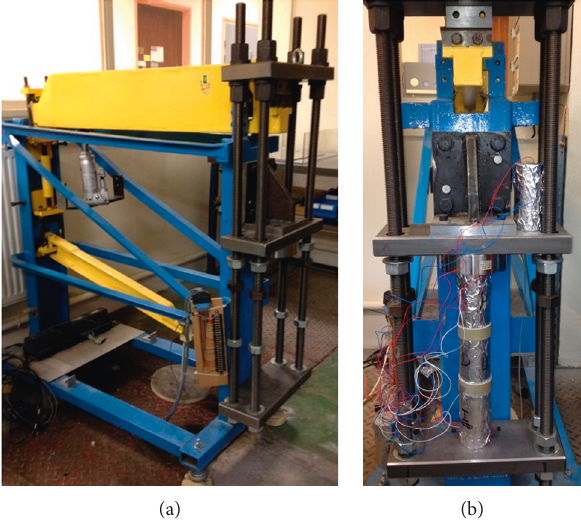
Figure 5: (a) Side view of the creep device; (b) front view of the creep device with a column arrangement containing 3 specimens.